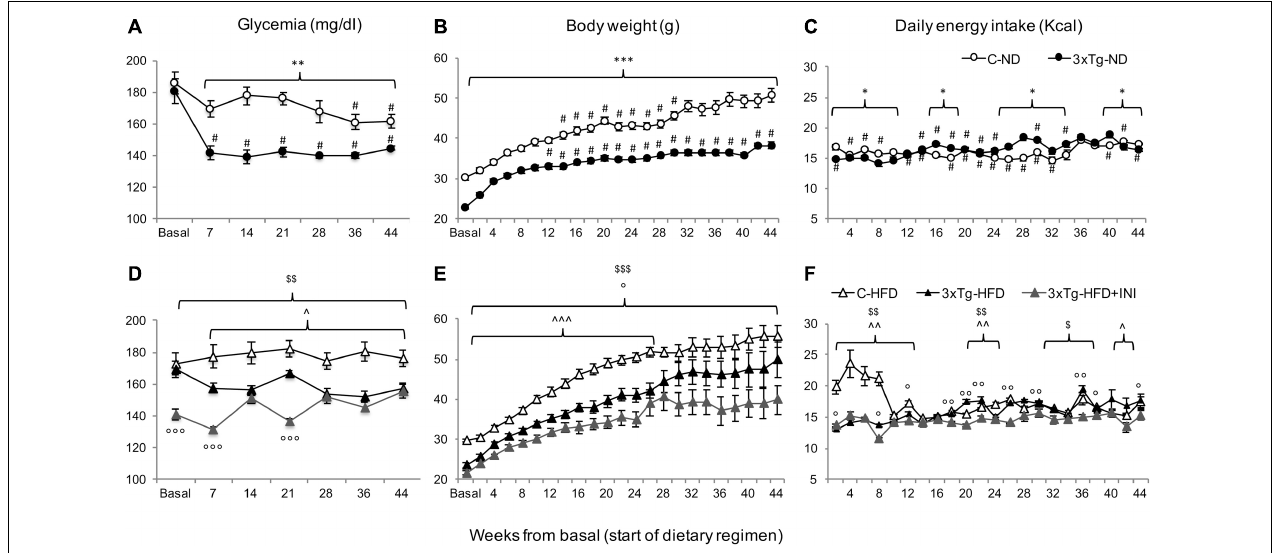
FIGURE 2 | The figure documents lower glycemia (A,D) and body weight (B,E) , and higher energy intake (C,F) in 3 × Tg compared to diet-matched controls, with an effect of chronic INI to reduce all parameters (D–F) . Data are presented as mean ± SEM. Sample sizes are given in Table 1 . Panels A–F ∗ p < 0.05, ∗∗ p < 0.01, ∗∗∗ p < 0.001 between groups (within-panel), # p < 0.05 ND (A–C) vs. HFD (D–F) within-strain (between panels), panels D–F ∧ p < 0.05 or less ( ∧∧ ) C-HFD vs. 3 × Tg-HFD, $ p < 0.01 C-HFD vs. 3 × Tg-HFD + INI, ◦ p < 0.05 or less ( ◦◦ , ◦◦◦ ) 3 × Tg-HFD vs. 3 × Tg-HFD + INI.